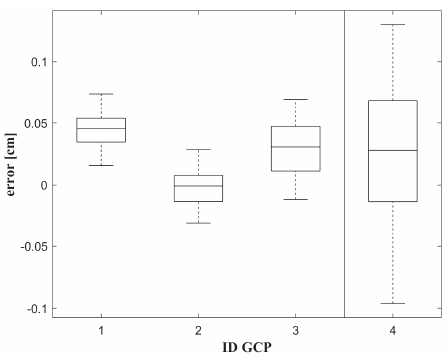
Figure 4. Boxplot of errors between estimated and observed water level values at the four Ground Control Points (GCPs).